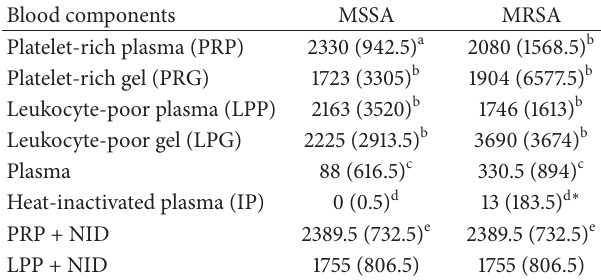
Table 7: PDGF-BB (pg/mL) concentration in every blood compo- nent cultured with either MSSA or MRSA at 24